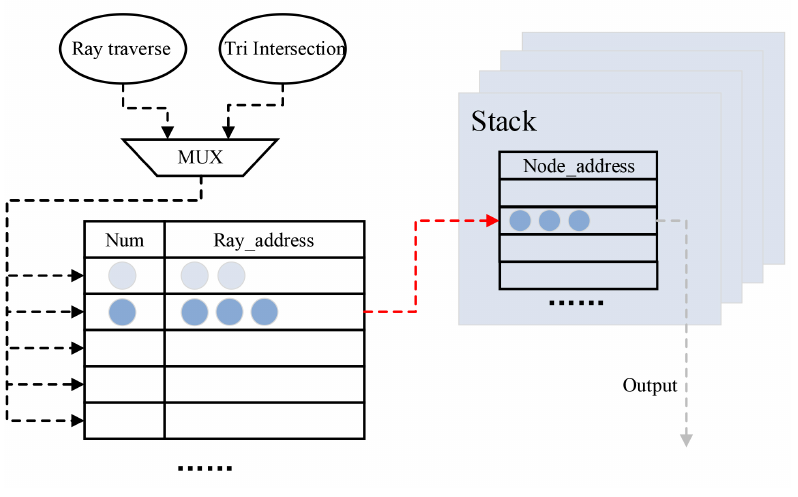
Figure 2. Multiple stacks